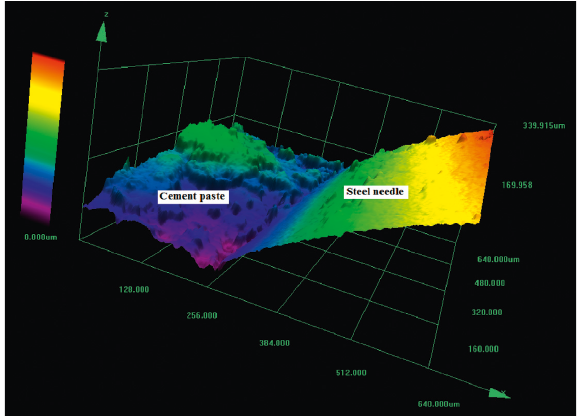
Figure 4: Microscopic three-dimensional topography of the transition zone between cement paste and the steel needle. The laser confocal microscope Olympus Lext 3100 has been used. The format of the image: 640 μ m 640 μ m, 1024 pixels 1024 pixels, vertical × × z step 0 . 09 μ m, total height 334 μ m, and magnification (cid:31) Δ